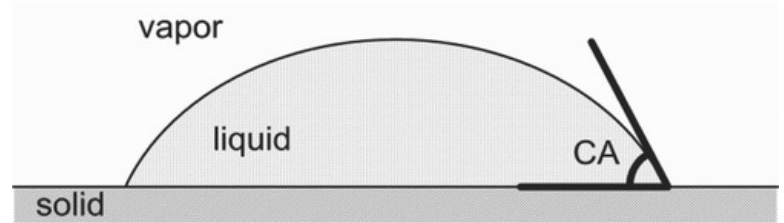
Figure 4. CA determination on a solid surface [10].